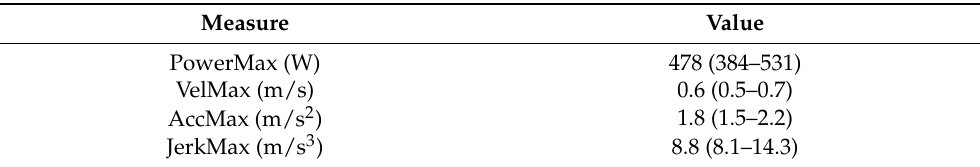
Table 7. Descriptive data for the leg strength sensor-test (n = 31). Variables are described in terms of the median (Q1–3) values.